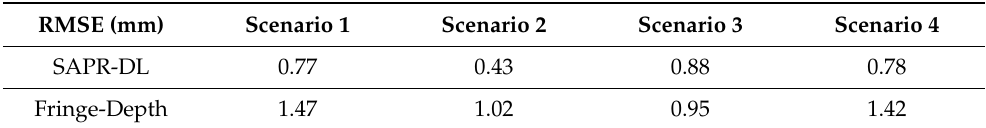
Figure 5. Absolute phase retrieval results based on the proposed SAPR-DL method. ( a – d ) The captured low-frequency fringe images. ( e – h ) Absolute phase maps (ground truths). ( i – l ) Absolute phase maps (SAPR-DL). ( m – p ) The absolute phase error maps of the proposed SAPR-DL method. Table 2. Quantitative comparison of the proposed SAPR-DL method and Fringe-Depth method in terms of RMSE of depth